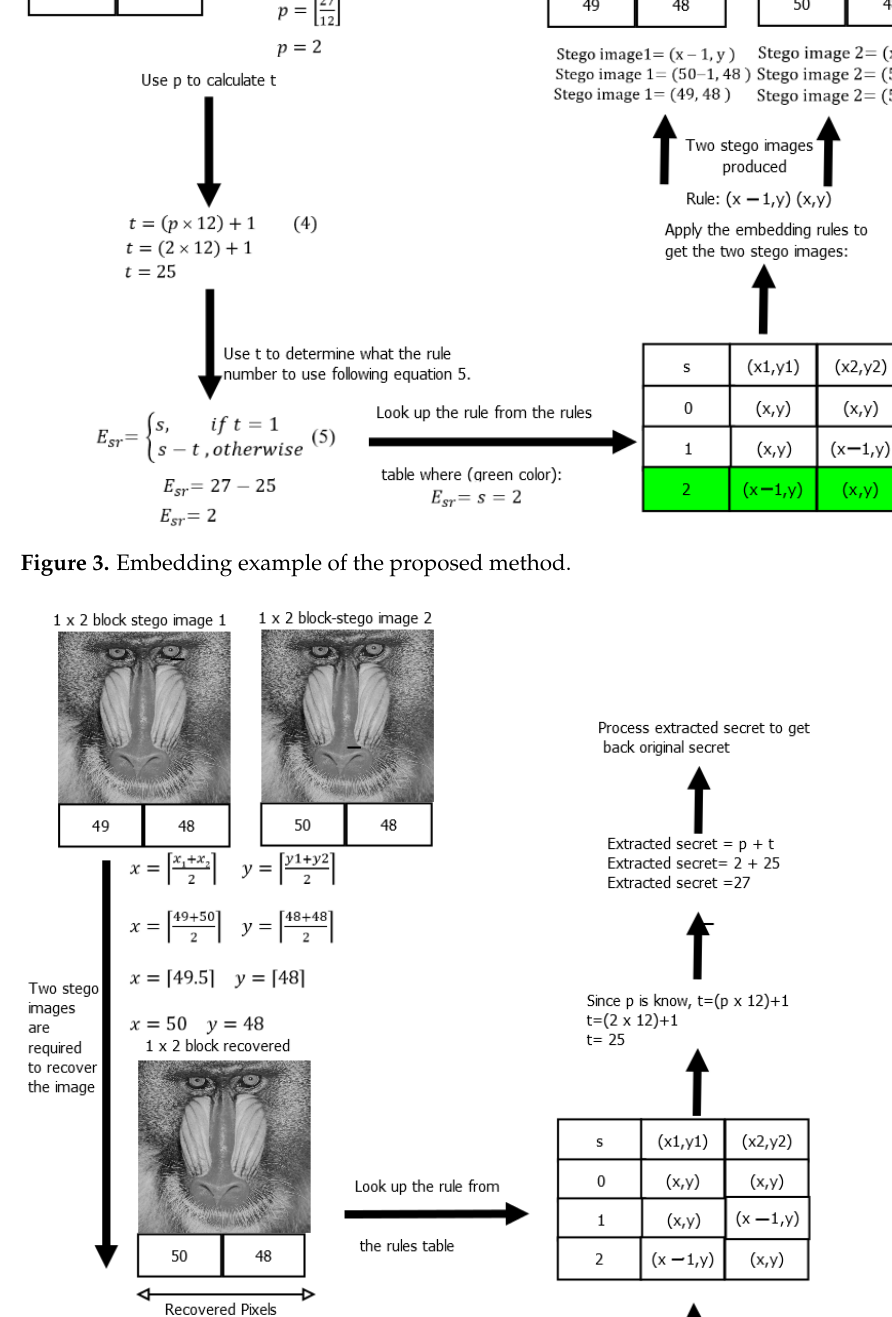
Figure 4. Extraction example of the proposed method.